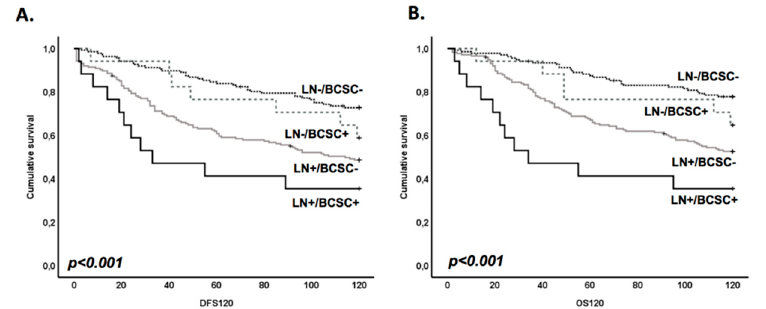
Figure 5. BR-BCSC signature strongly predicts a poor overall survival in lymph node-positive breast cancer patients. Kaplan–Meier analysis of DFS ( A ) and OS ( B ) using the BR-BCSC signature in both lymph node-positive and lymph node-negative breast cancer. LN-positive cases with a BR-BCSC signature were from patients who exhibited the worst DFS (59.8 ± 11.8 months vs. 79.0 ± 3.5 months in LN-positive cases with no BR-BCSC signature) and OS (60.4 ± 11.8 months vs. 86.2 ± 3.2 in LN-positive cases with no BR-BCSC signature).